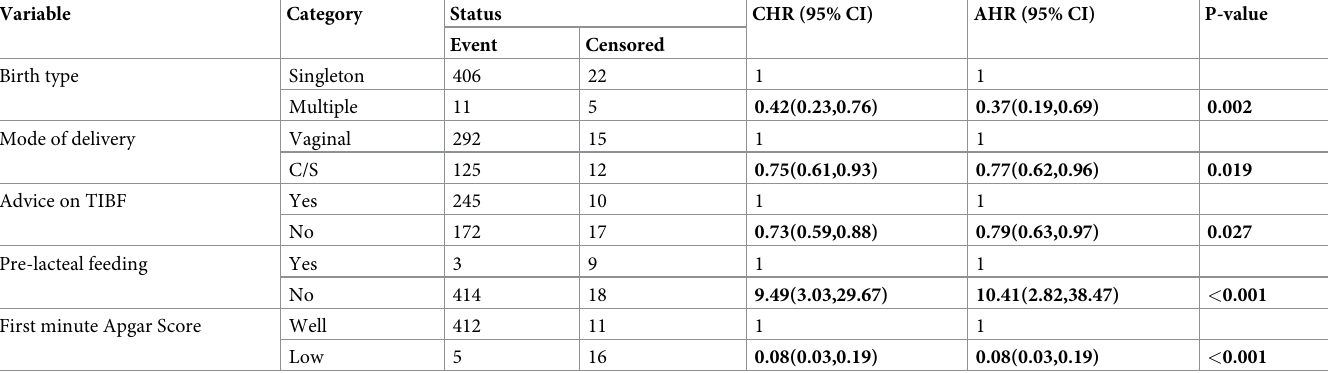
Table 5. Predictors of time to initiation of breastfeeding among postnatal mothers within 12 hours of giving birth in Debre Markos Comprehensive Specialized Hospital, North West, Ethiopia, 2020.